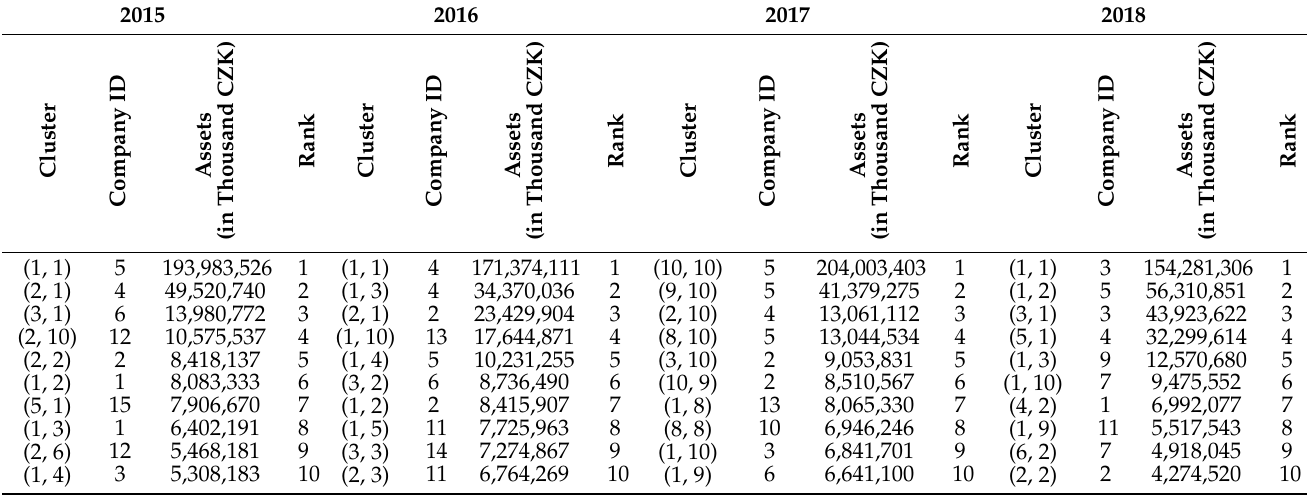
Table 2. Cluster tables and variables including